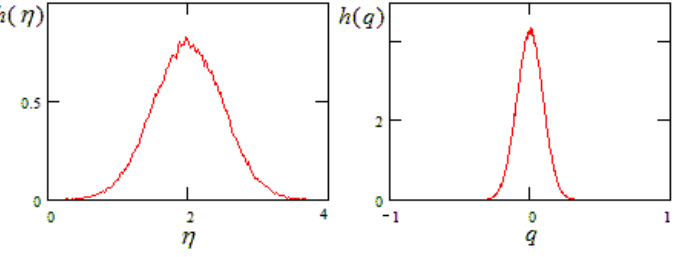
Figure 5: The distributions of the noise h ( η ) and of the order parameter h ( q ) for the noisy mean- field model in the monomer